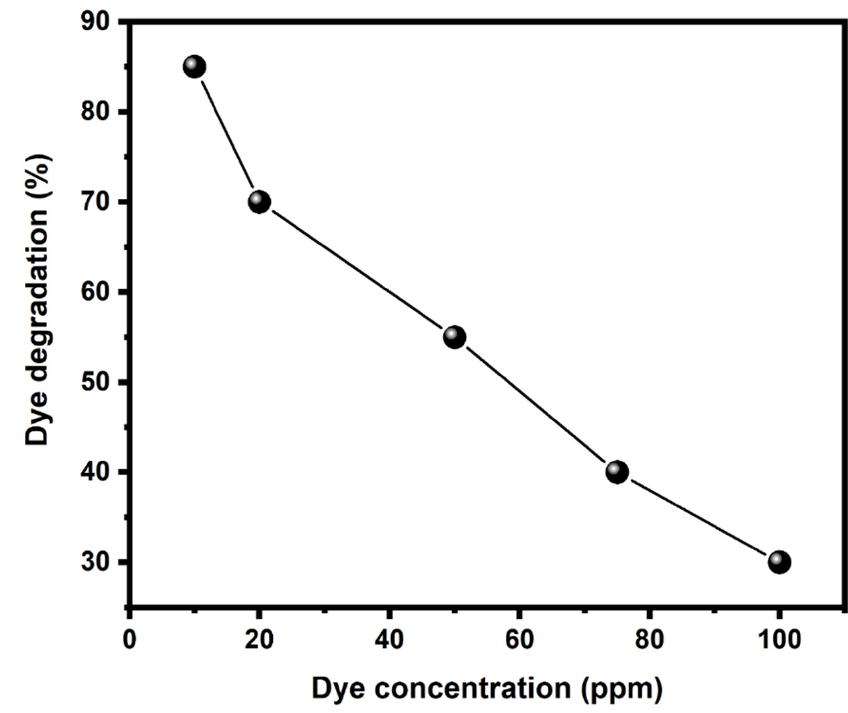
Figure 10. Effect of dye concentration on degradation (%) by TiO 2 .